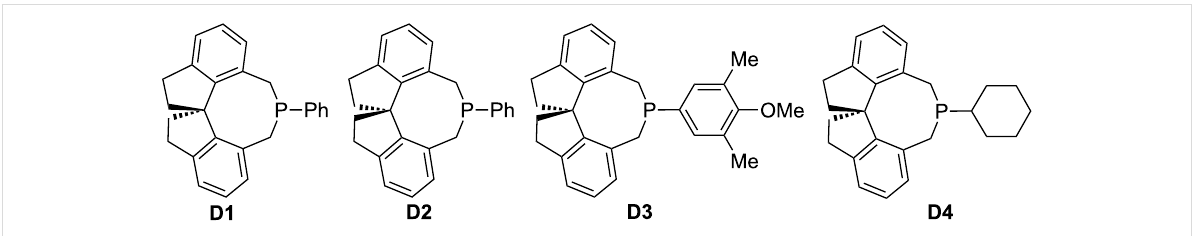
Figure 4: Cyclic chiral phosphines based on spirocyclic skeletons.